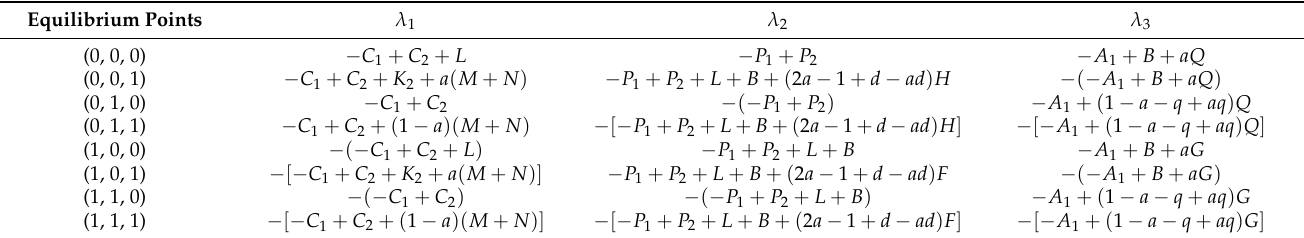
Table 2. Eigenvalues of equilibrium